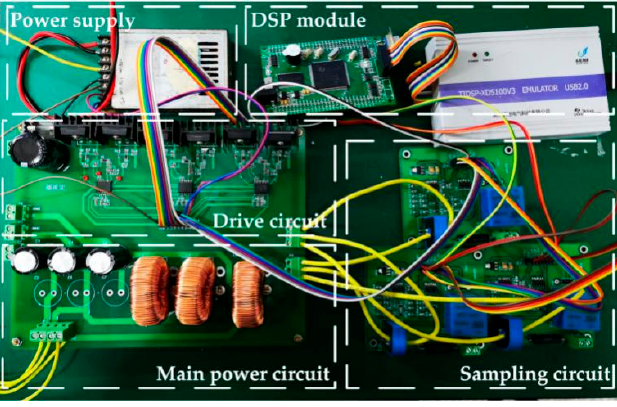
Figure 20. The experimental model of the synchronverter-based RBE feedback system.